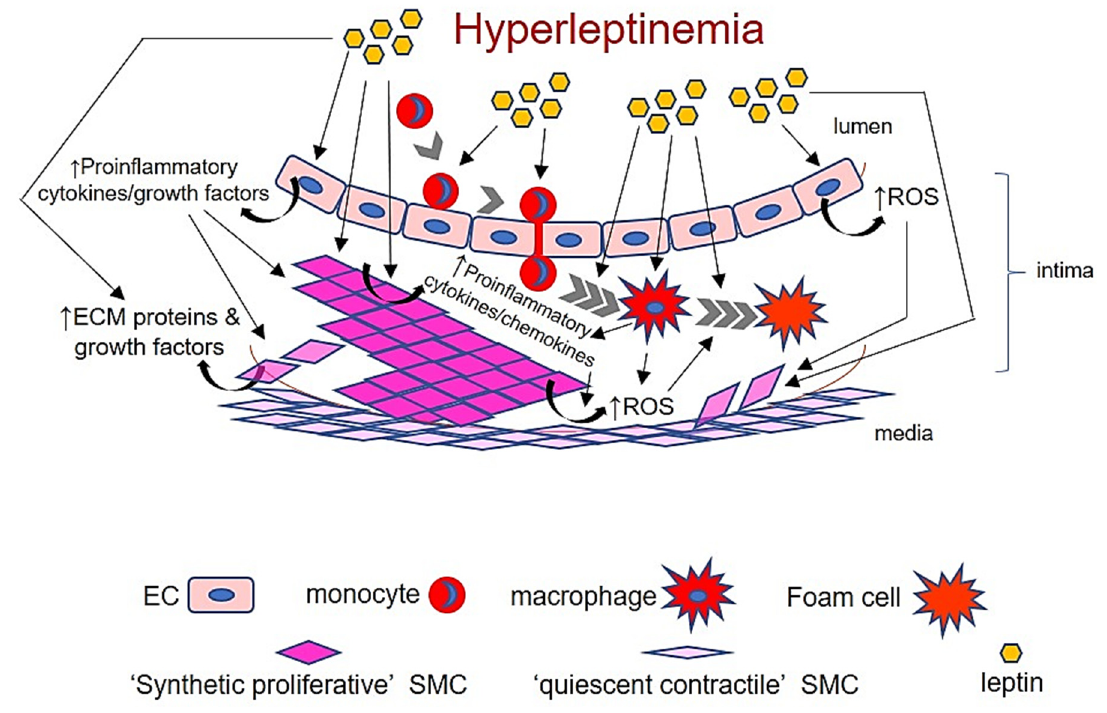
Figure 5. Cross-talk between EC, SMC and macrophages in response to hyperleptinemia in the vessel wall. ECM: extracellular matrix; ROS: reactive oxygen species. Please see text for details.